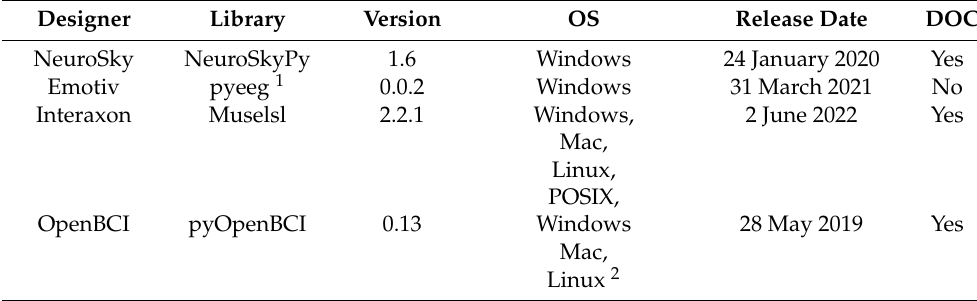
Table 2. Available EEG library for targeted consumer devices in PyPI.